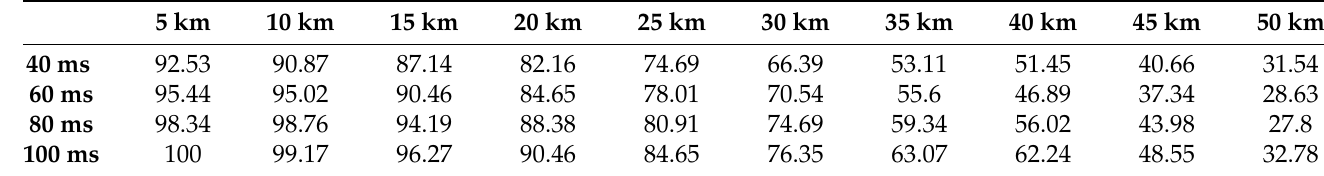
Table 1. RTK fix rate (in percentage) for different integration times at different baselines.